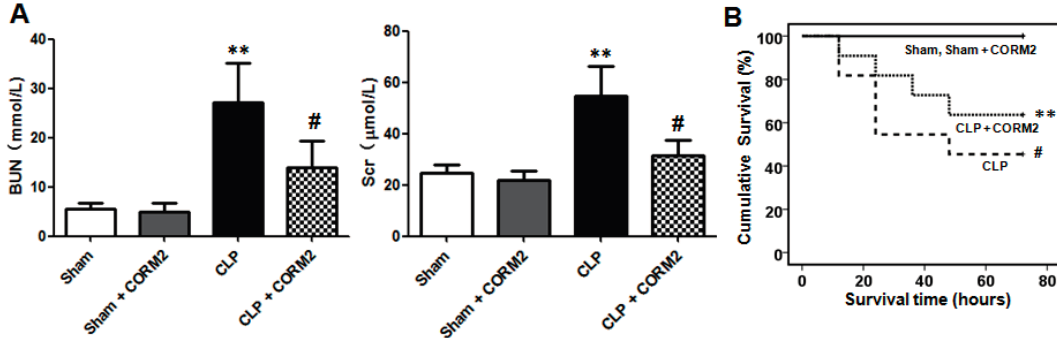
Figure 1. Effects of carbon monoxide on acute kidney injury and survival of septic